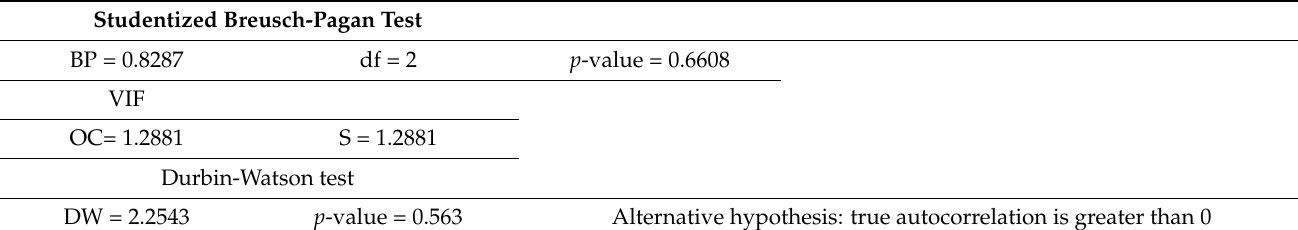
Table 9. Two-factor model heteroscedasticity, multicollinearity, and autocorrelation